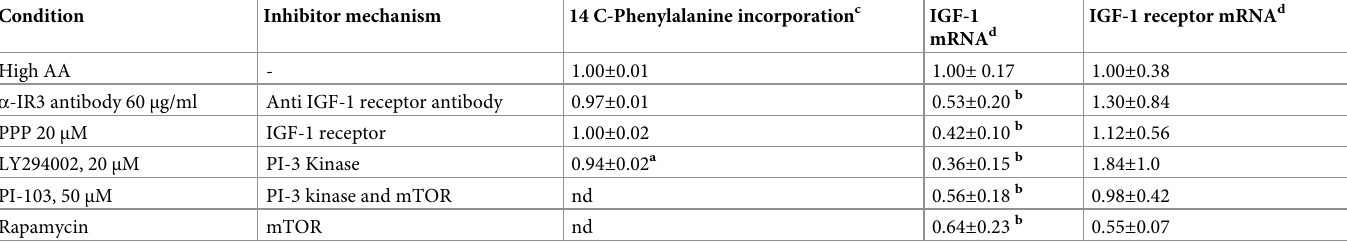
inhibitors (Table 1). Table 1. IGF-1, IGF-1receptor mRNA, and L-[U-14C]-phenylalanine incorporation into proteins, in confluent non-proliferating L6 skeletal muscle cells. Cells were amino acid refed at High AA concentrations (9 mM) with or without presence of inhibitors of molecules in the IGF-1receptor signaling pathway (mean ± SE, n = 4-5/